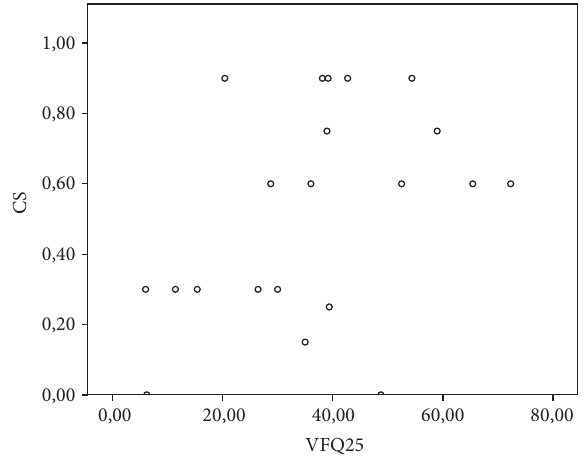
Figure 8: Scatterplot showing the significant correlation between CS and total questionnaire score as per the Pearson coefficient of 0.409 ( 𝑝 = 0.033